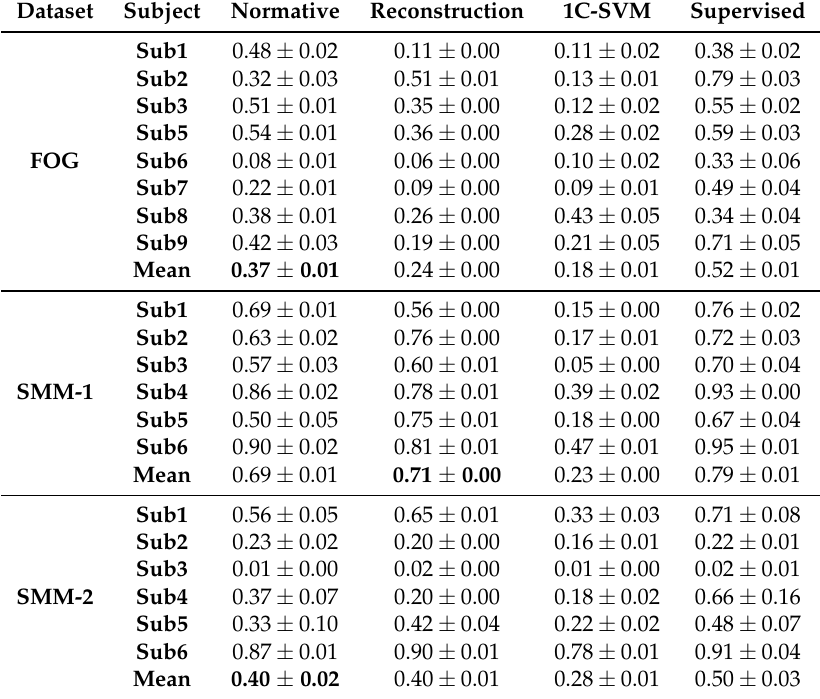
Table 3. The average AUPR for novelty detection using normative modeling, reconstruction-based and one-class-SVM on three benchmark datasets.